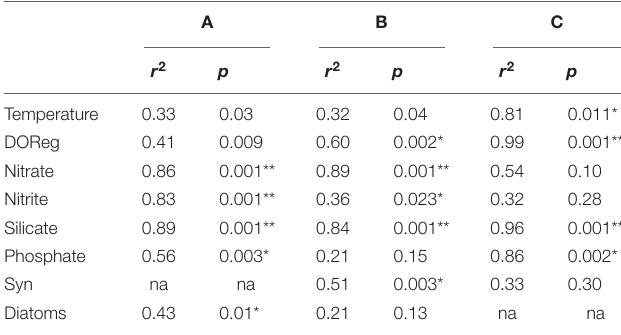
TABLE 4 | CCA ( Figure 5 ) ordination site scores with environmental variables (97% cutoff; A–C refer to Figures 5A–C ),